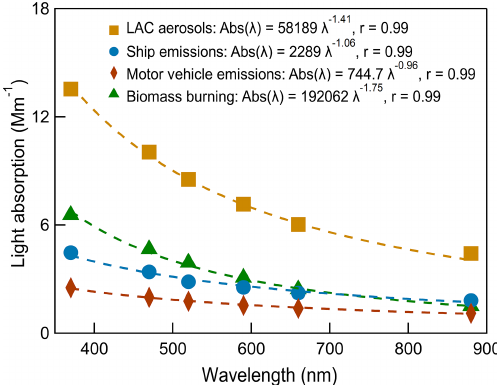
Figure 5. The light absorption (Abs( λ) ) of light-absorbing carbona- ceous (LAC) aerosols from ship emissions, traffic emissions and biomass burning. The dashed line is power-law